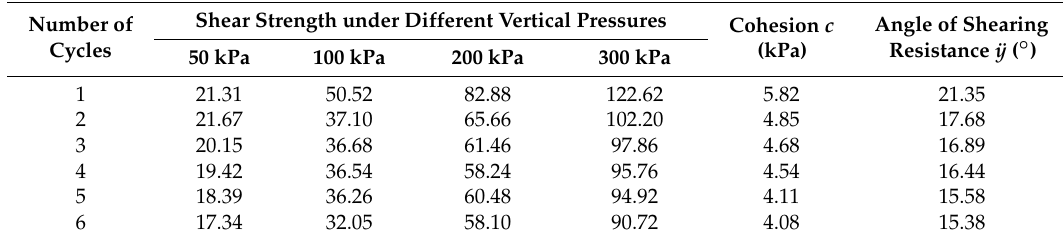
Table 1. Shear strength of tailings sand after dry-wet (DW)